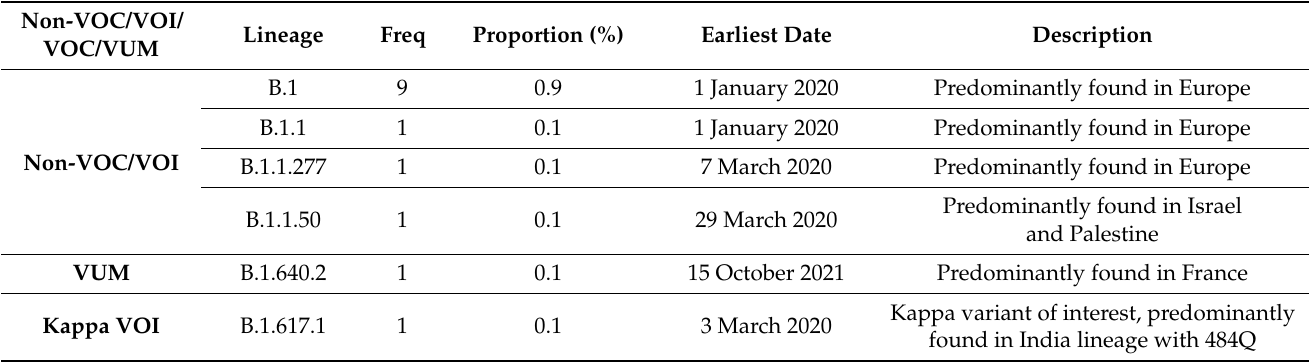
Table 2. Description of SARS-CoV-2 lineages observed in Seychelles, their global history and VOC/VOI